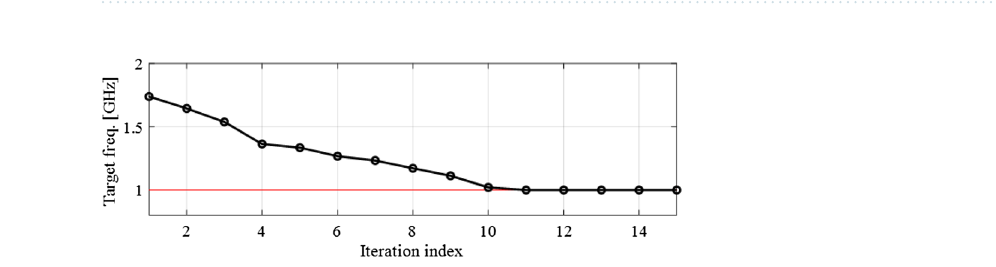
Figure 6. Branch-line coupler: scattering parameters at the initial (gray) and the final design (black) obtained using the proposed design specification management methodology. Target operating frequency marked using the vertical line.